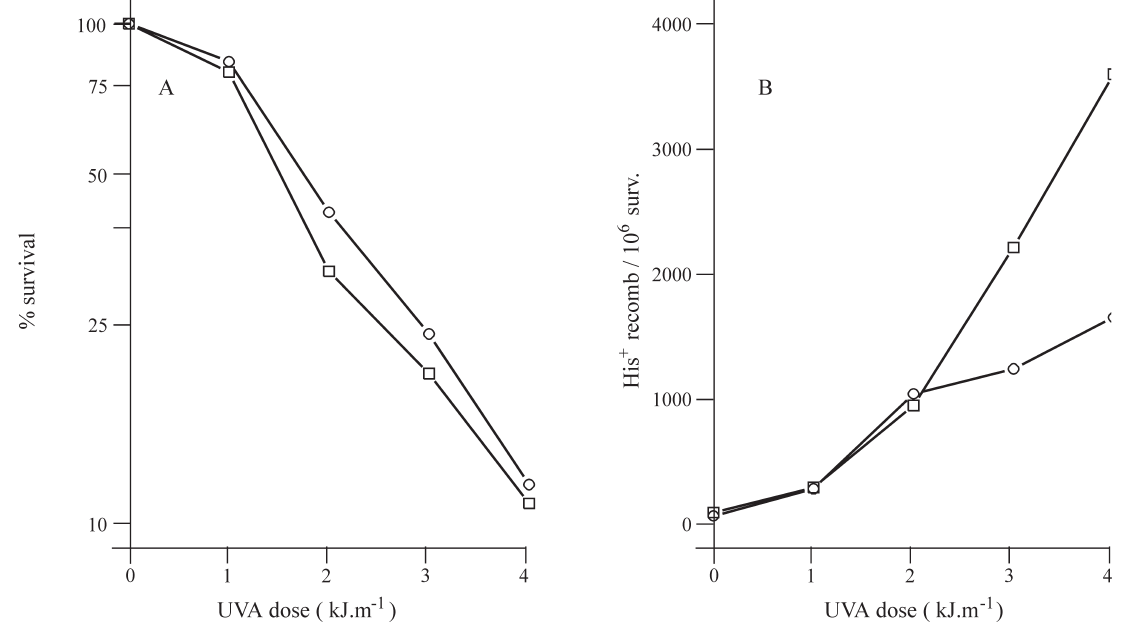
Figure 3 - Effect of 8-MOP+UVA (365 nm) treatment on the percentage cell survival (Figure A) and intrachromosomal recombination rate (Figure B) of stationary phase mitotic haploid yeast cells harboring the recA gene, symbols as in Figure